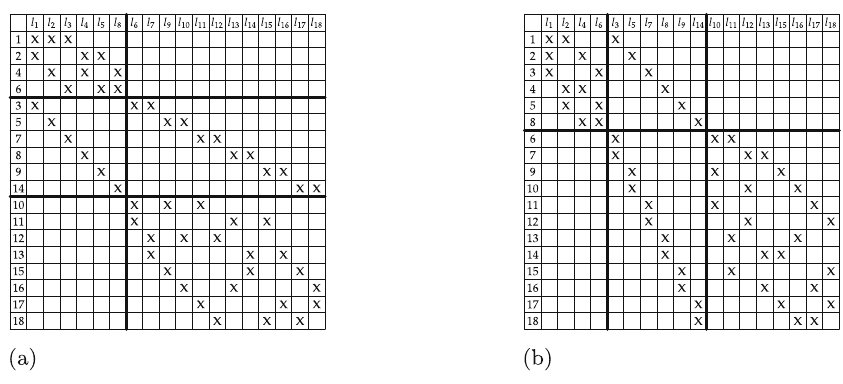
Figure 20: A pair of dual 18 348 - con fi gurations. ( a ) An incidence matrix associated with an 18 348 - con fi guration inducing a triangular matroid. It is ( 3, 2 )- orbits and it consists one of the six 3 - regular graphs on 8 points. ( b ) The dual of ( a